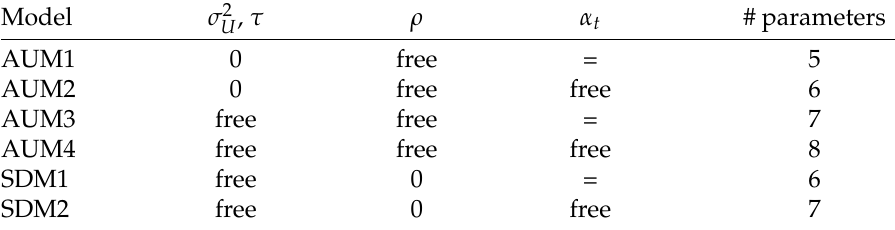
Figure 2: General model. Table 1: Candidate models and their parameter